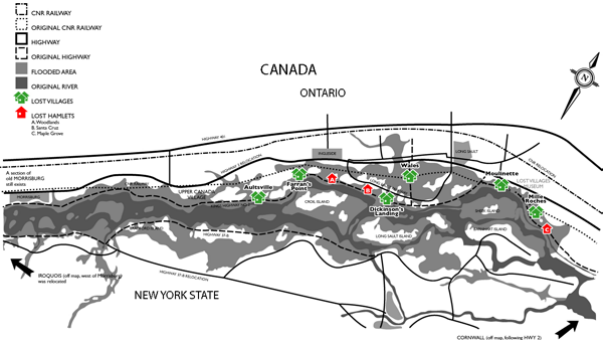
Figure 2. Map of Lake St. Lawrence